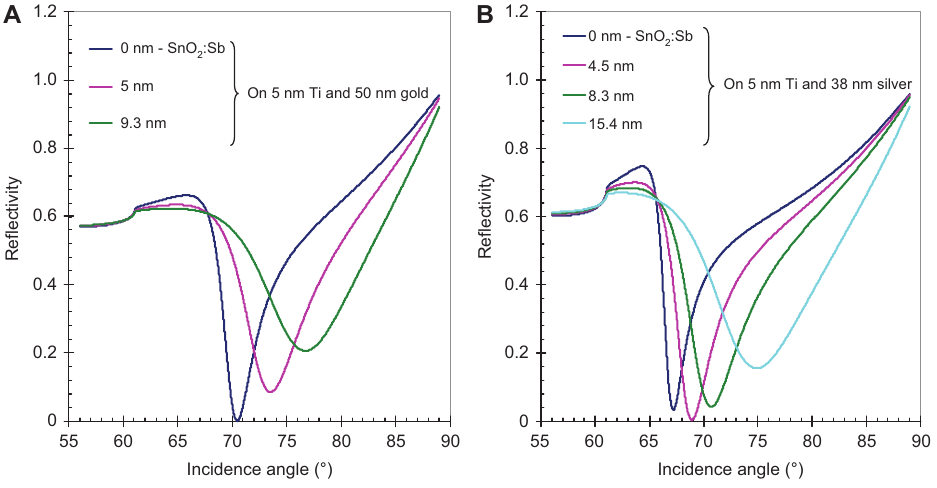
Figure 9 Infl uence of the SnO eters used for calculations: n